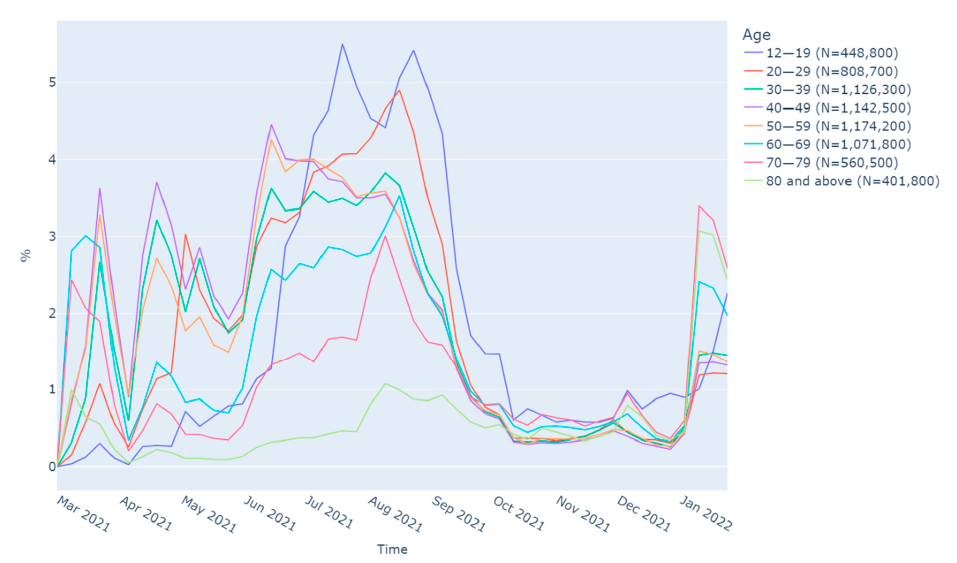
Figure 3. Absolute change in weekly vaccination rate of COVID-19 vaccine in Hong Kong by age group. The extent of the increment of change in the VR in the younger and middle age groups was found to be larger in the first and second peaks while the change in the VR of the elder age groups increased in a larger magnitude than the younger ones in the third peak.